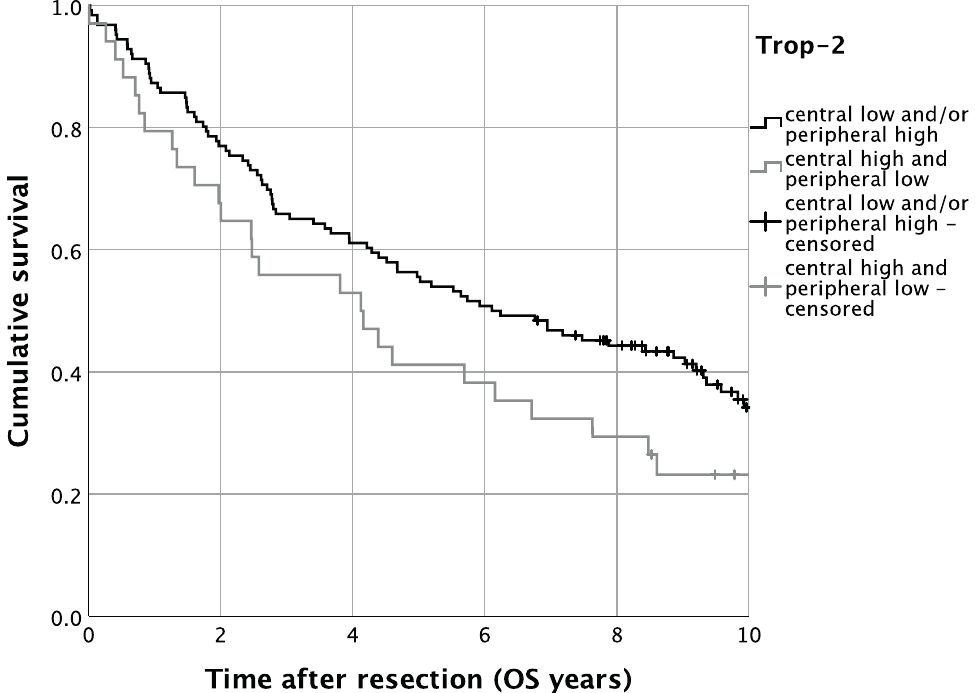
Figure 6. Kaplan–Meier analysis for varying Trop-2 H-scores for overall survival (OS). n = 160. p =